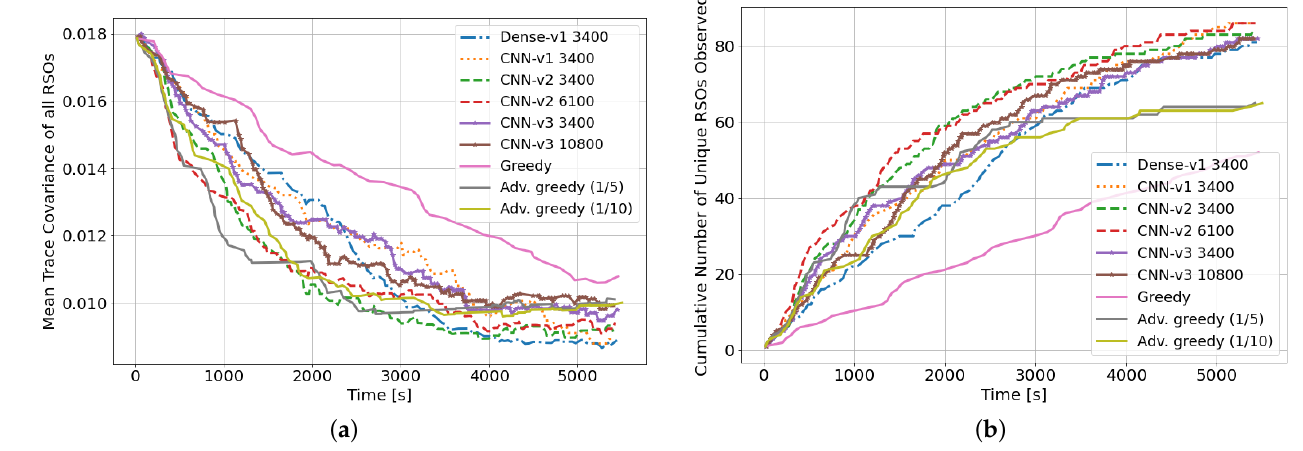
Figure 6. Performance of DRL agents with different architectures trained using 100 GEO RSOs, evalu- ated on a single-seeded rollout of 90 min. ( a ) Mean trace covariance of all RSOs for one rollout episode (lower is better); ( b ) Cumulative number of unique RSOs observed for one rollout episode (higher is better). Note: CNN-v1 3400 represents a CNN-v1 DRL agent trained for 3400 training